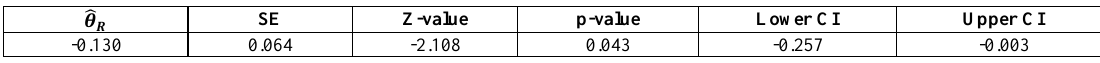
Table 3. Estimate for random effects